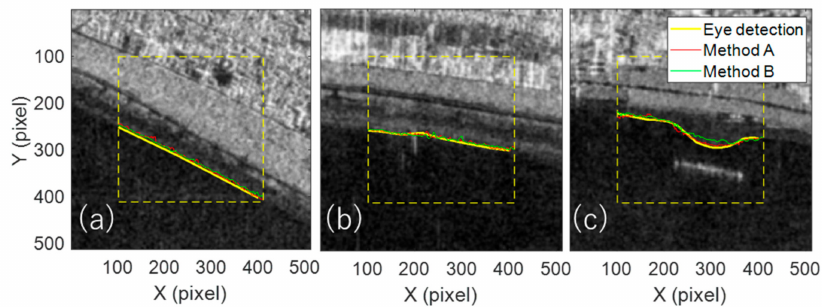
Figure 10. Comparisons of shoreline locations extracted through the proposed NN-based model and through eye detection. Three images, ( a – c ), correspond to those shown in Figure